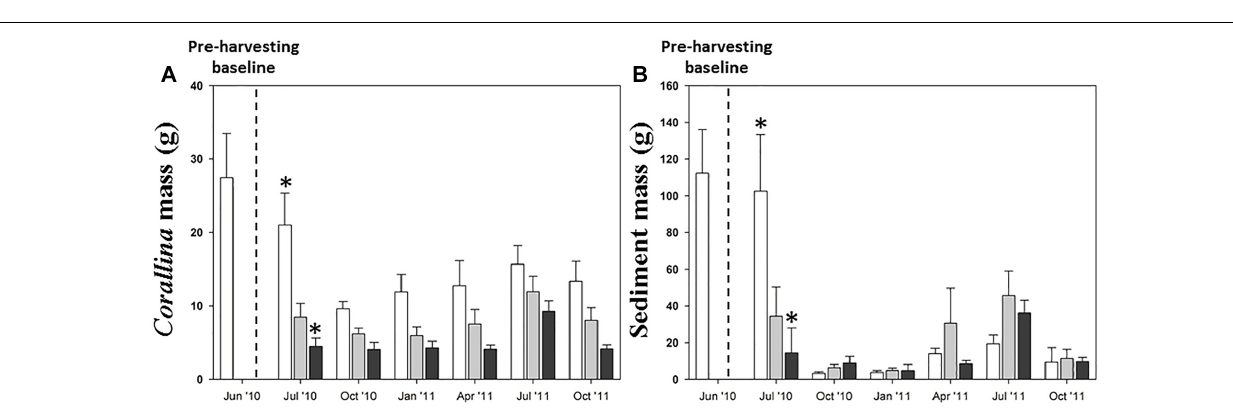
FIGURE 7 | (A) Corallina and (B) sediment mean mass ( ± SE) in experimental harvesting treatments (unharvested control, unshaded; cut, light gray; pull, dark gray). ∗ Significant differences between treatments (Tukey’s HSD, p <